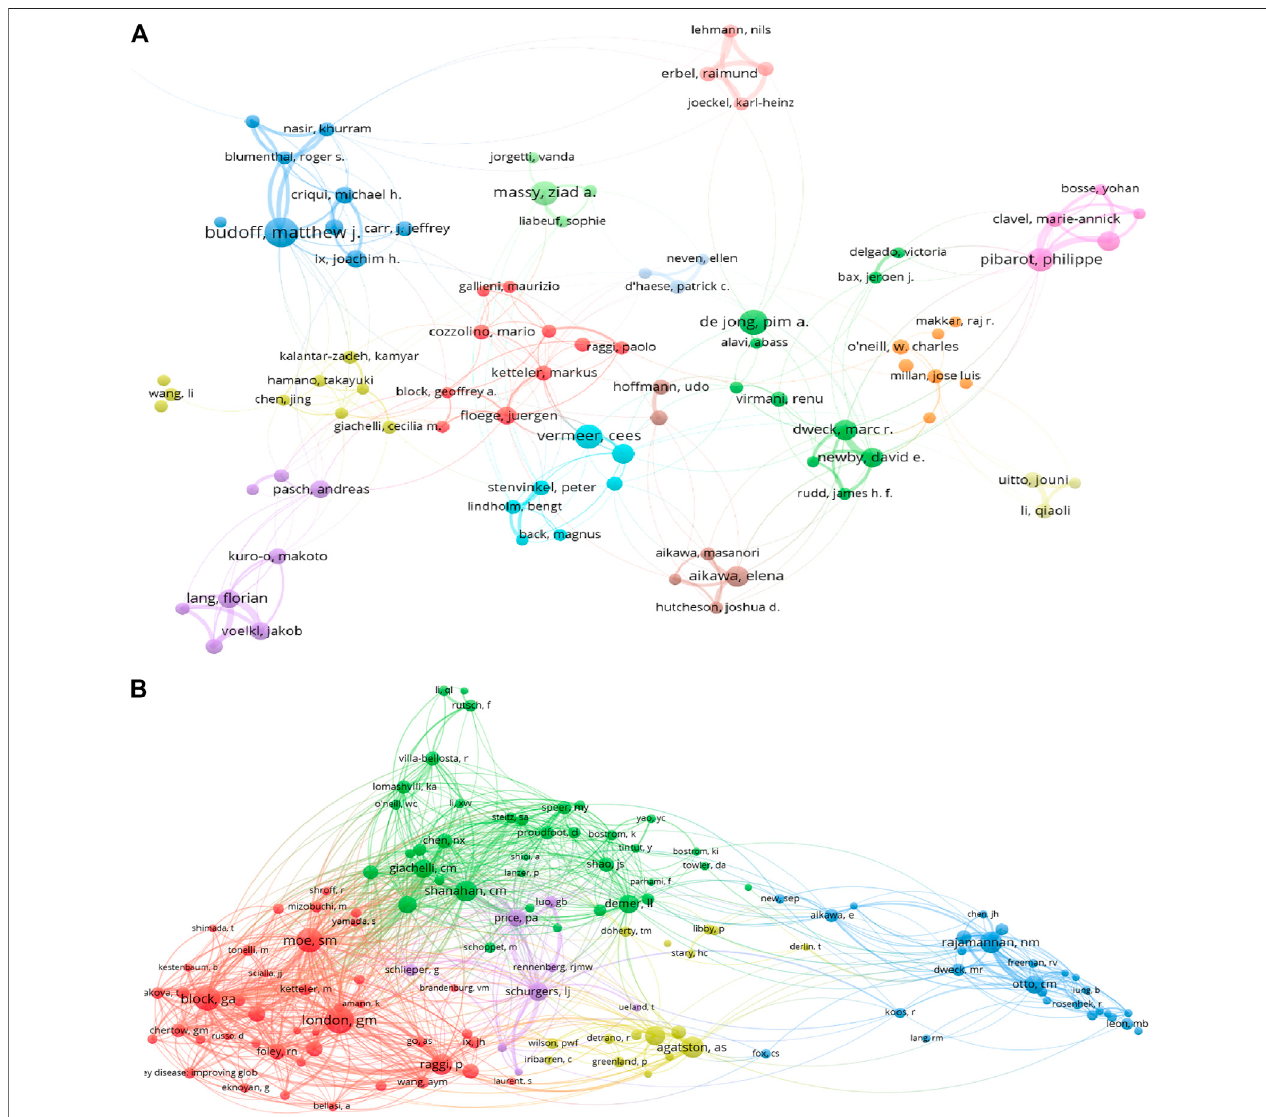
FIGURE 3 | VOSviewer visualization map of authors and co-cited authors devoted to vascular calci fi cation research. (A) Cooperation network of authors. Of the 42,046 authors, 113 had published at least 15 documents. (B) Co-citation network of authors. Of the 90,638 co-cited authors, 254 had at least 100 citations.